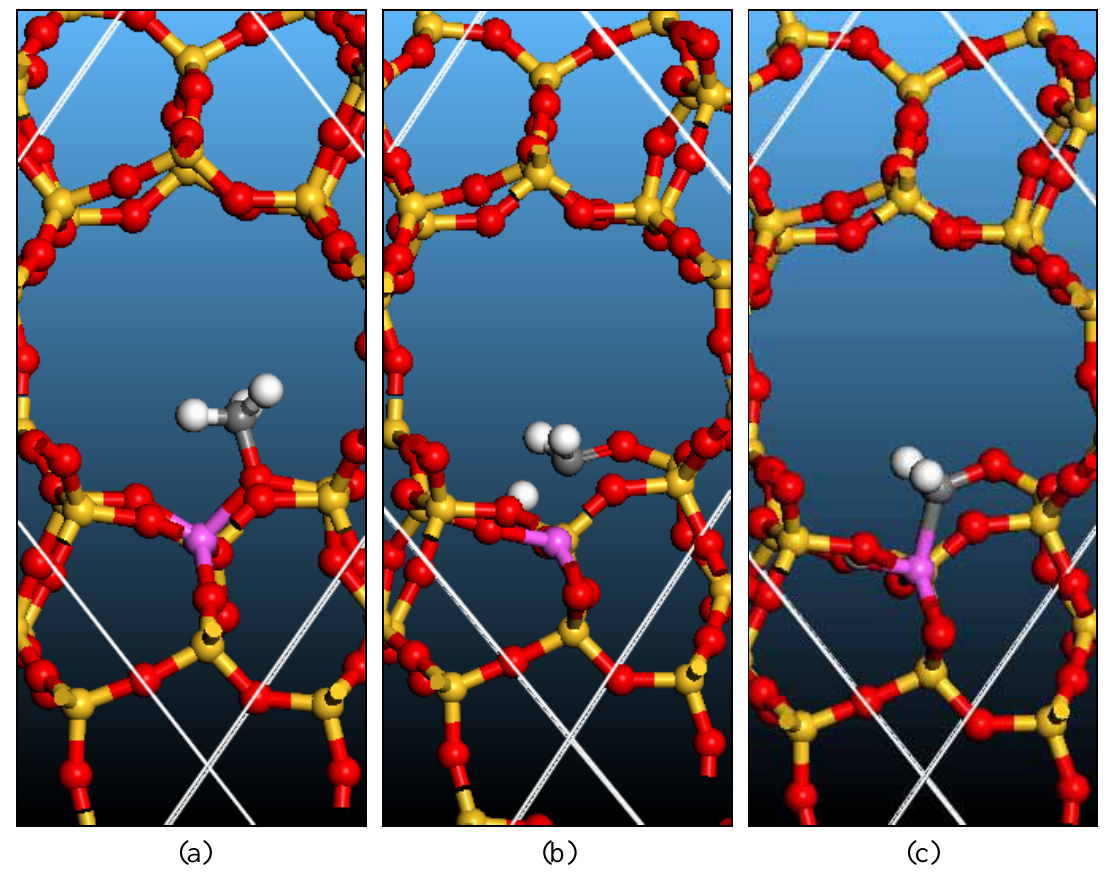
Figure 6. Incorporation of ylide into zeolite framework. (a) Surface methoxyl, (b) Transition state structure, (c) ylide structure incorporated into framework. Note the substantial lattice distortion around the Brønsted acid site as well as the zeolite cage.